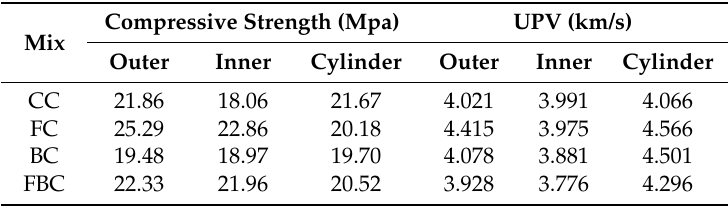
Table 5. Strength and UPV values of inner and outer cores of all four groups.